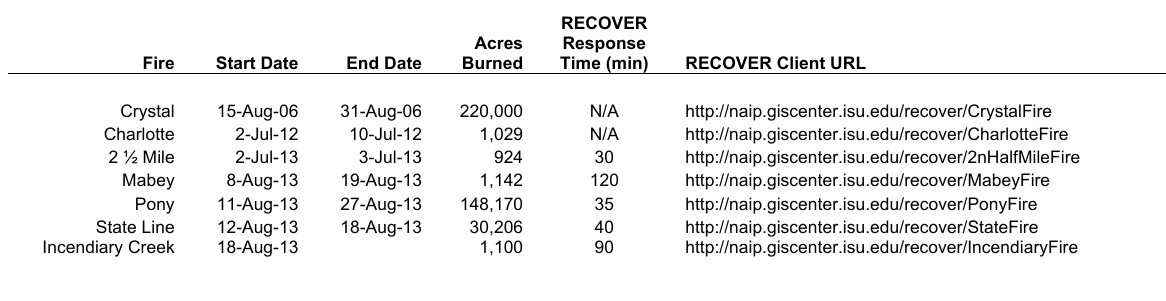
Table 1. RECOVER feasibility study